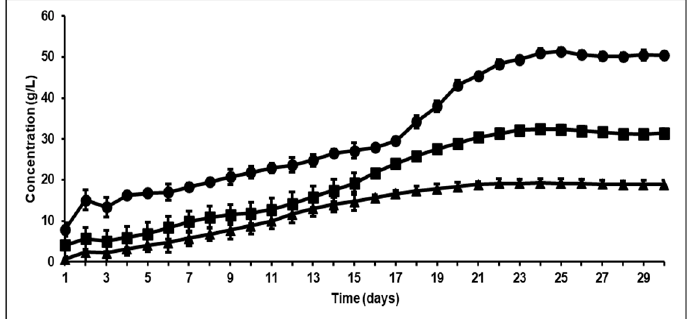
Figure 2. Comparison between total VFA concentration (g/L) as a function of time in control